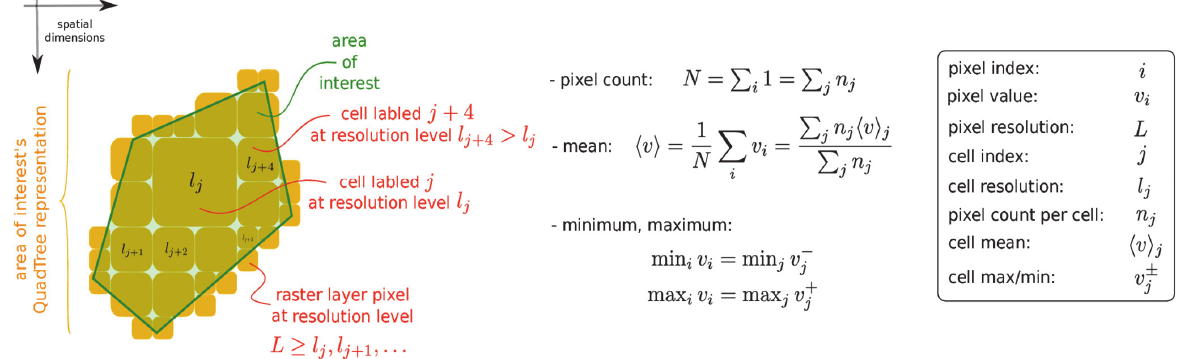
Figure 5: Illustration of efficient analytics exploiting the generation of overview layers in